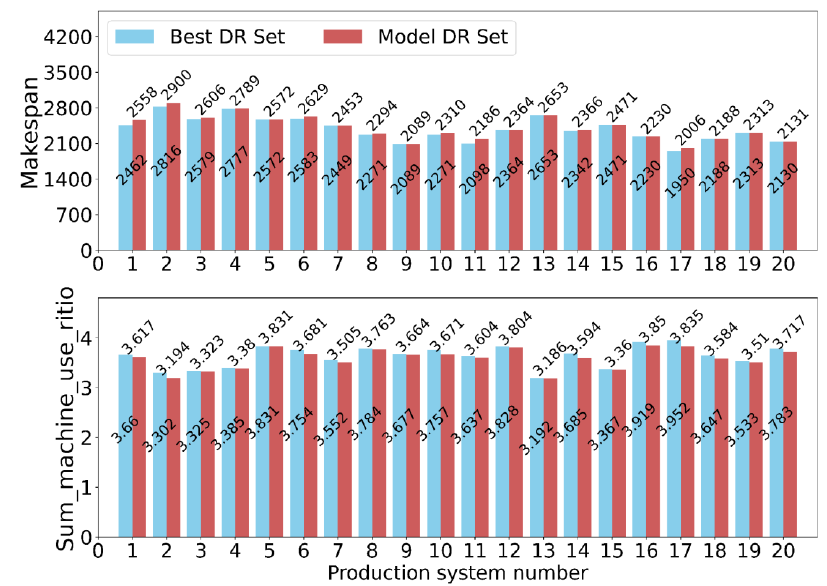
Figure 15. Low job heterogeneity and a high manufacturing system load rate.